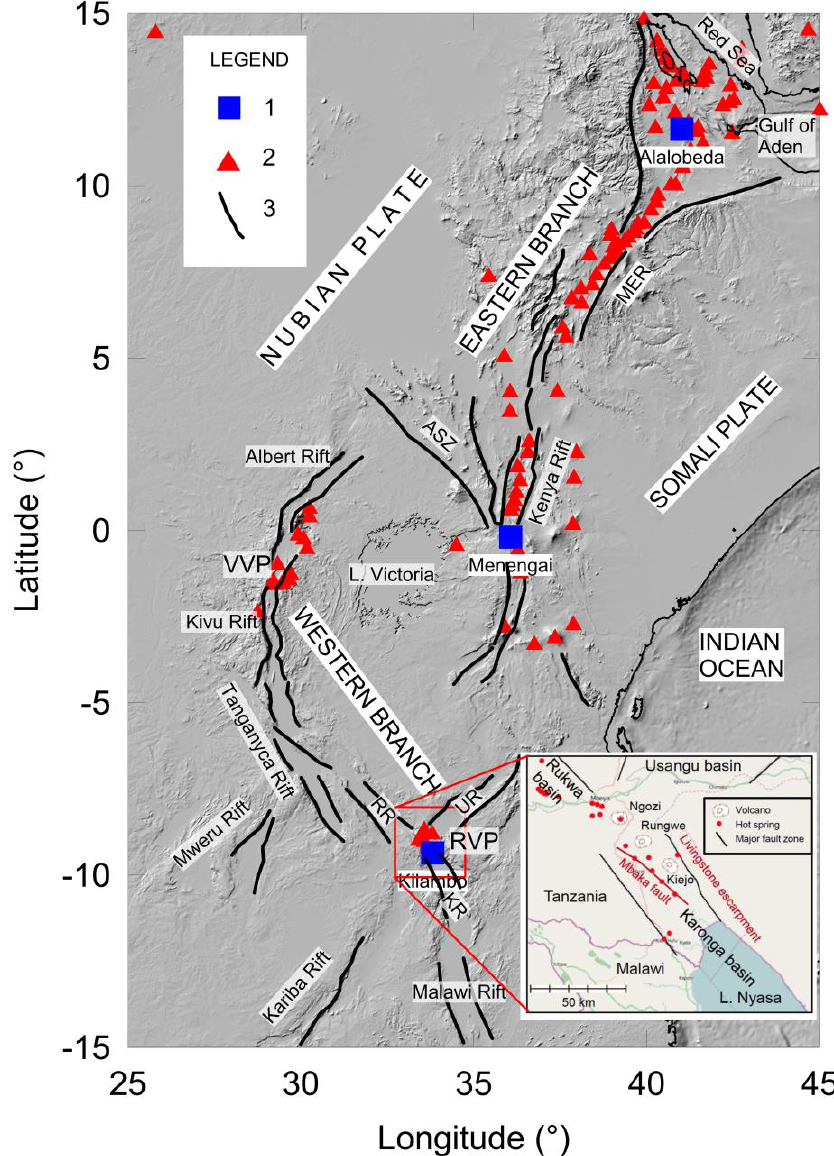
Figure 1. Structural sketch of the East African Rift System (EARS). (1) location of the investigated geothermal plays (Alalobeda, Menengai and Kilambo-Ilwalilo); (2) major active faults; (3) volcanoes. MER-Main Ethiopian Rift; ASZ-Aswa shear zone; RR-Rukwa Rift; UR-Usangu Rift; KR-Karonga Rift; VVP-Virunga volcanic province; RVP-Rungwe volcanic province. Inset: major geological elements around the Kilambo-Ilwalilo geothermal play.